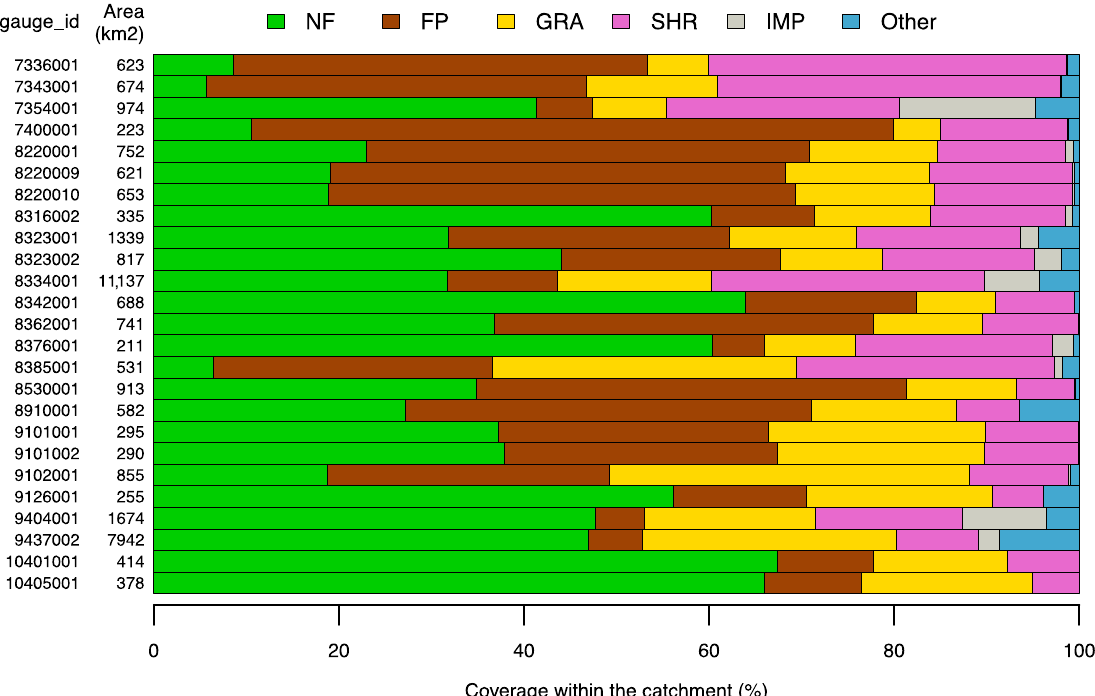
Figure 2. Land cover composition of study catchments (NF: native forest; FP: forest plantation; GRA: grassland; SHR: shrubland, IMP: impervious). The catchments are ordered from north to south. Watersheds identifier (gauge_id) and basin area obtained from CAMELS-CL attributes are provided at the y -axis.